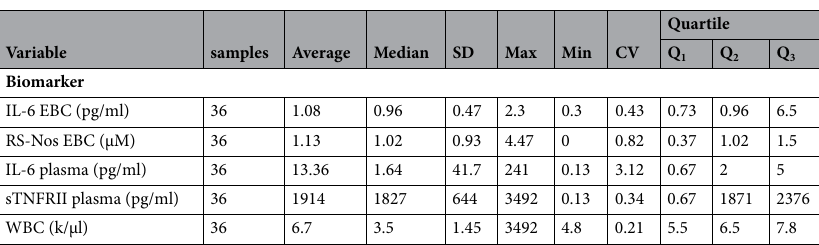
Table 6. Description of measured biomarkers in the second sampling period